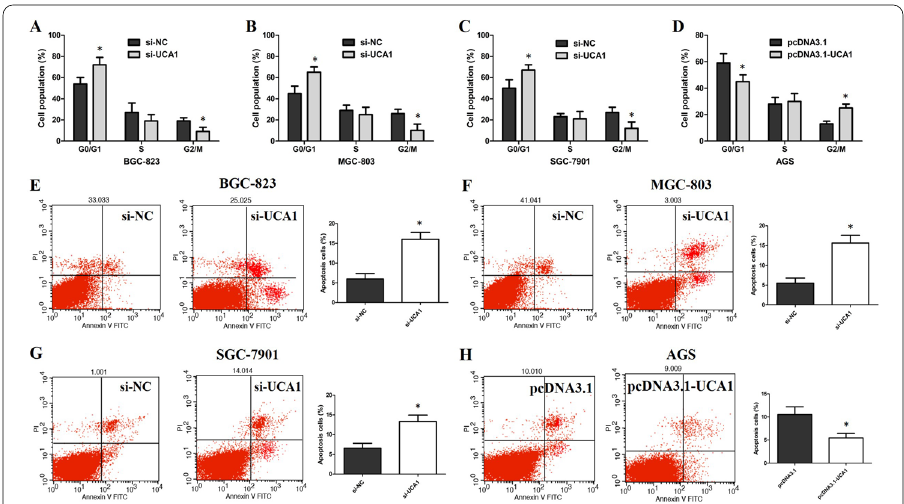
Fig. 4 UCA1 downregulation causes G1 arrest and apoptosis in GC cells in vitro. A Flow cytometry assay showed that BGC-823 cells transfected with siUCA1 had G0/G1 phase arrest. B Flow cytometry assay showed that MGC-803 cells transfected with siUCA1 had G0/G1 phase arrest. C Flow cytometry assay showed that SGC-7901 cells transfected with siUCA1 had G0/G1 phase arrest. D Flow cytometry assay showed that AGS cells transfected with pcDNA3.1-UCA1 decreased the G0/G1 phase cell percentage and increased the G2/M phase cell percentage. E Flow cytometry assay showed that BGC-823 cells transfected with siUCA1 had a higher apoptotic rate. F Flow cytometry assay showed that MGC-803 cells transfected with siUCA1 had a higher apoptotic rate. G Flow cytometry assay showed that SGC-7901 cells transfected with siUCA1 had a higher apoptotic rate. H Flow cytometry assay showed that AGS cells transfected with pcDNA3.1-UCA1 had a lower apoptotic rate. *p < 0.05, compared with control